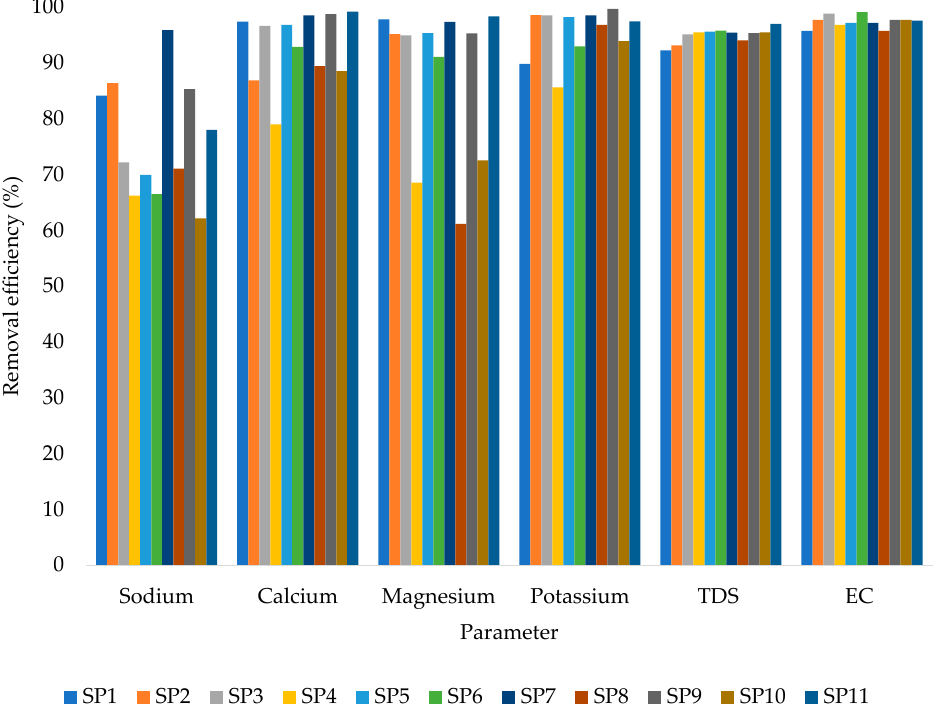
Figure 4. Removal efficiency from 1 m (V f : 0.0035 L/s; pH: 6.4–12.5; T: 22.6–24.4 °C; n = 8). SP1–SP11 are the sampling points (one to eleven).